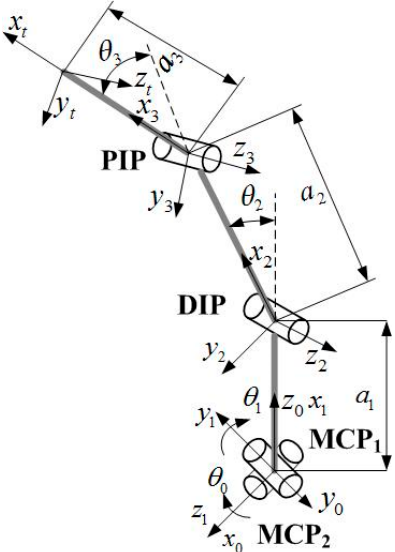
Figure 5. Structure diagram of the single exoskeleton finger.